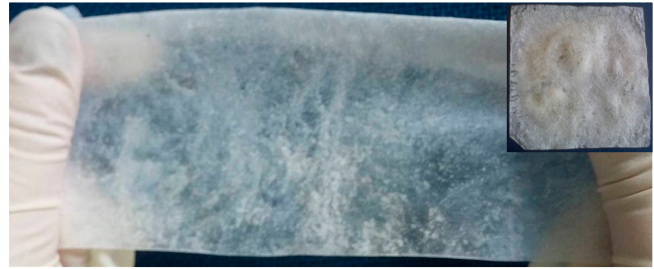
Figure 4. Membrane with P(ethylene- co -A Α c28)/P(SSNa- co -GMA0.2)/PEG composition 60/10/30 after the total removal of the water soluble polymer (PEG).